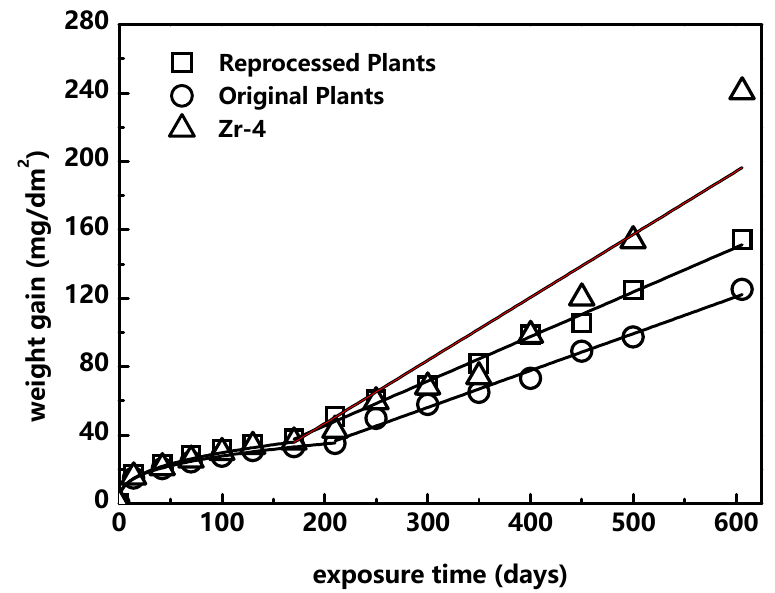
Figure 7. Corrosion kinetics of different materials.